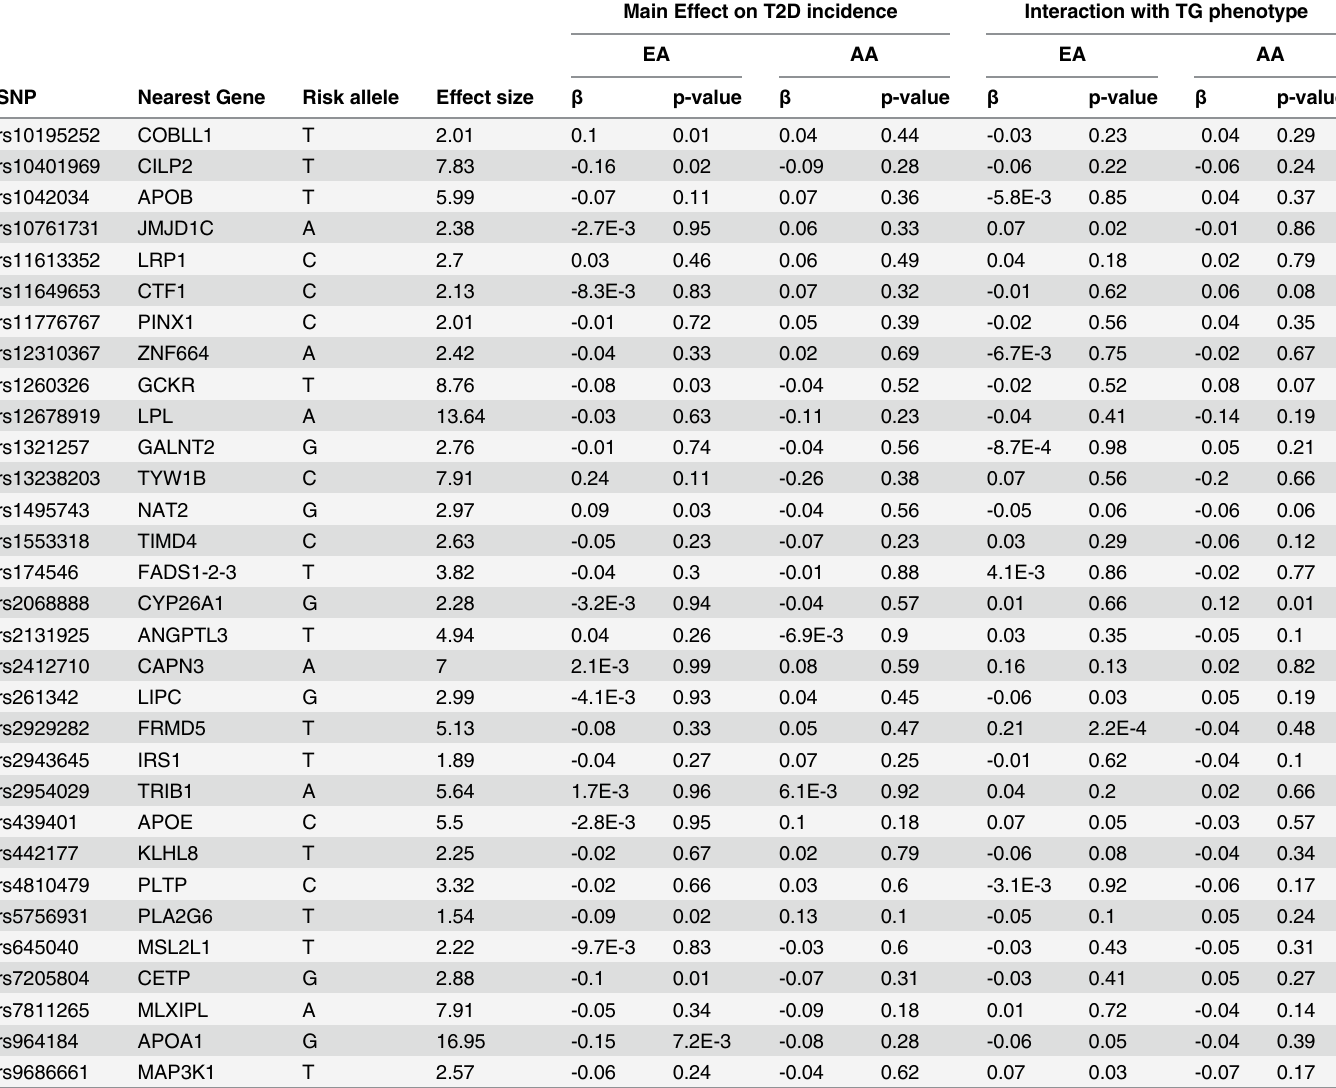
Table 2. List of 31 triglyceride (TG)-associated SNPs with their respective genomic position, risk allele (TG increasing), TG effect size (weight used in GRS), association with T2D incidence, and interaction with TG phenotype in European- and African-Americans (EA,